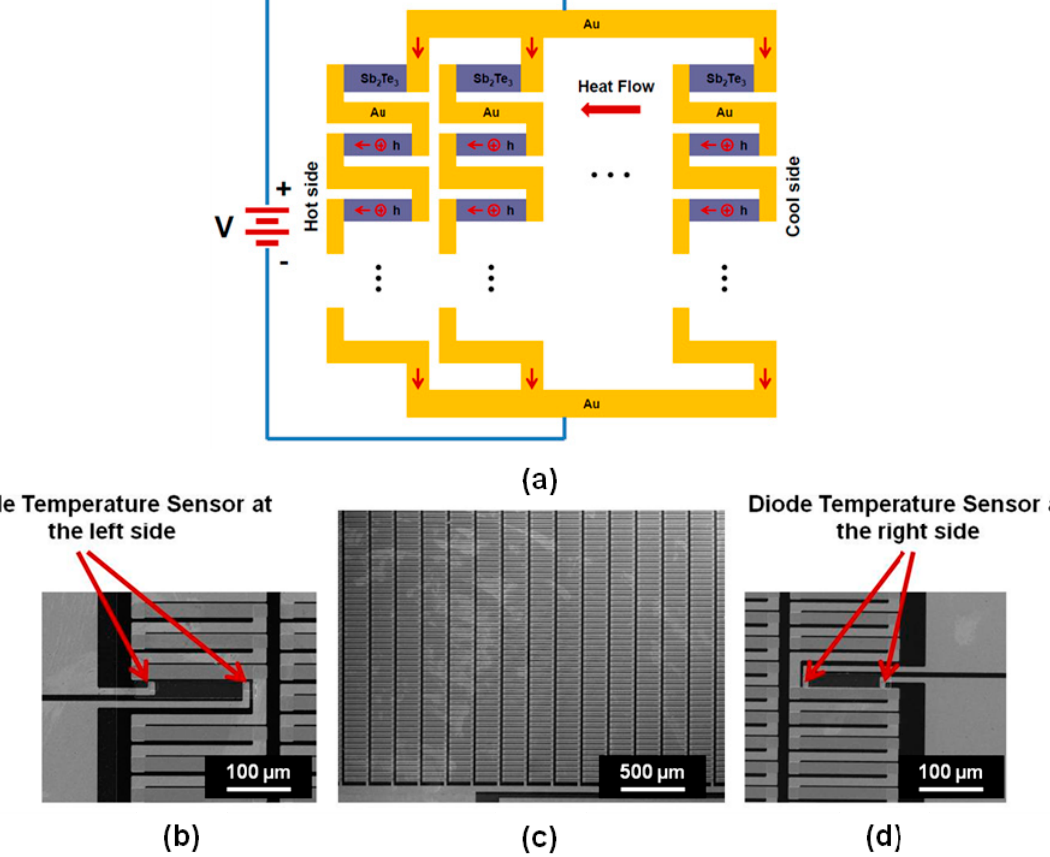
Figure 3. ( a ) Working principle for an in-plane integrated TE device of Sb 2 Te 3 thin film; ( b ) SEM image of an enlarge view on the area of left diode temperature sensors in the integrated TE device; ( c ) SEM image of a partial of the fabricated integrated TE device; ( d ) SEM image of an enlarge view on the area of right diode temperature sensors in the integrated TE